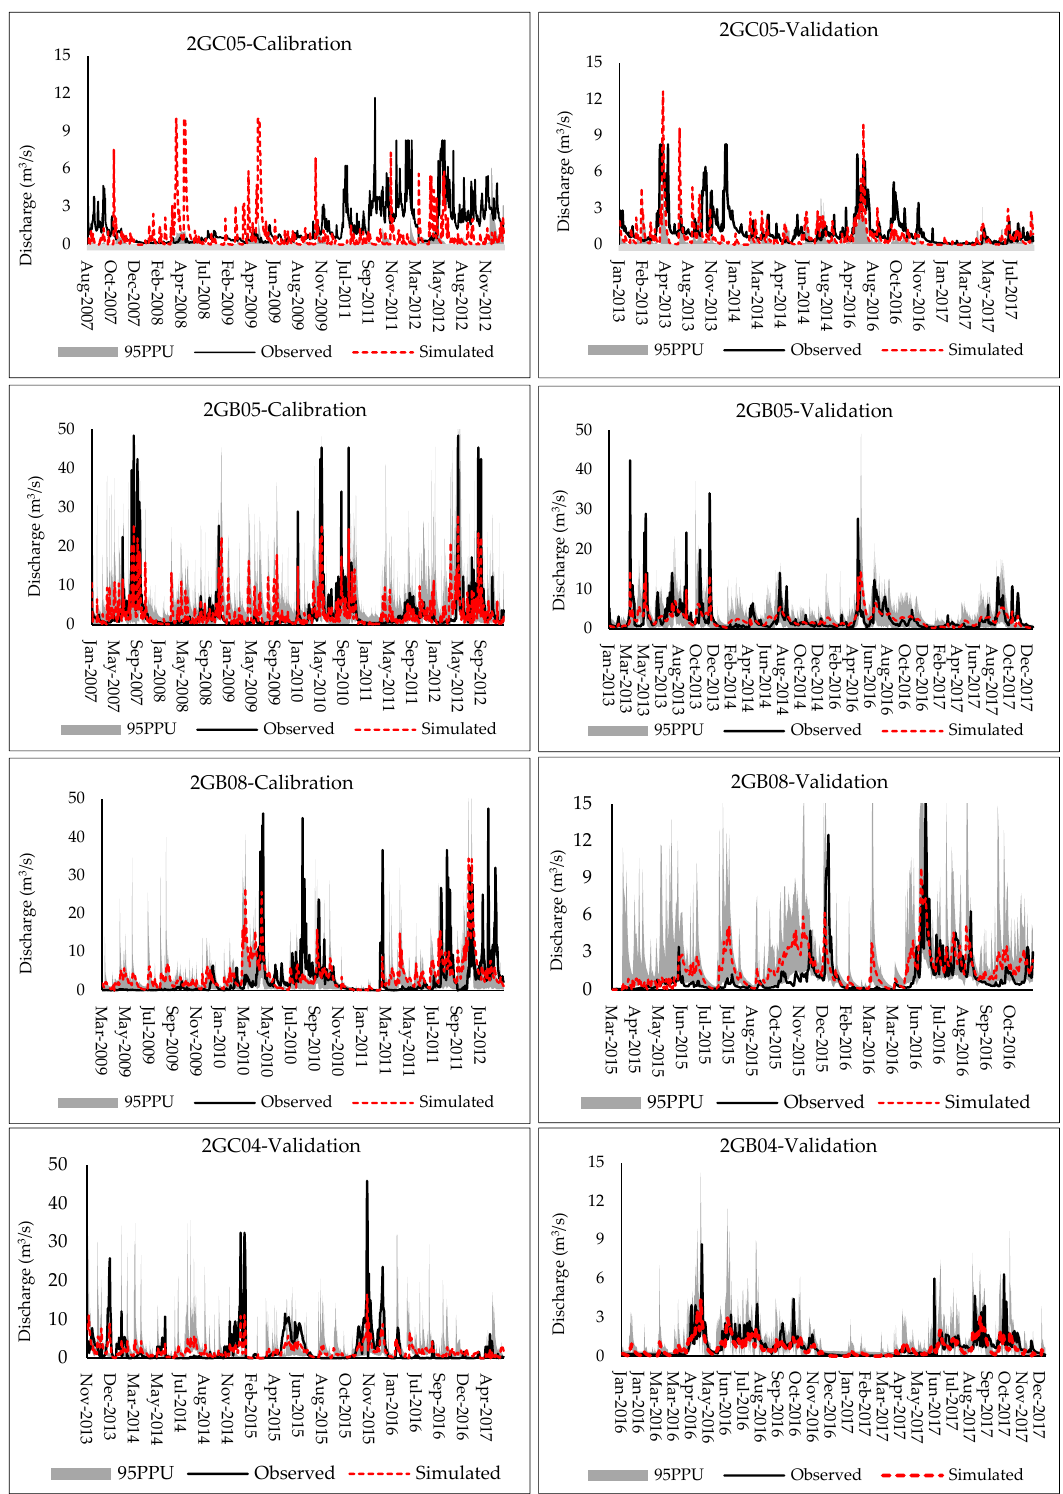
Figure 2. Daily discharge calibration and validation for different gauge stations.